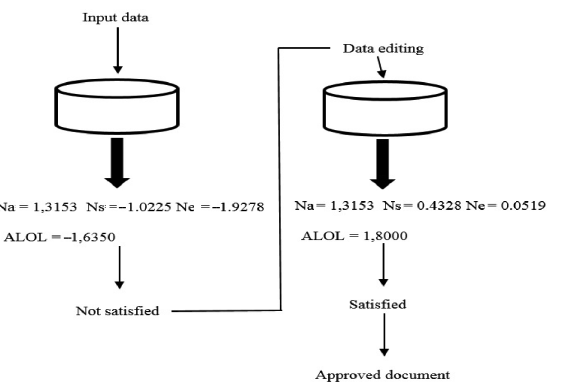
Figure 3. ALOL model operation example